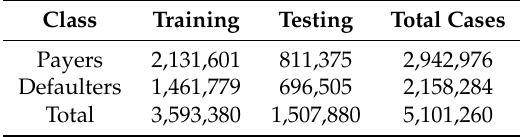
Table 2. Distribution of observations in the Spanish Institute of Fiscal Studies (IEF)